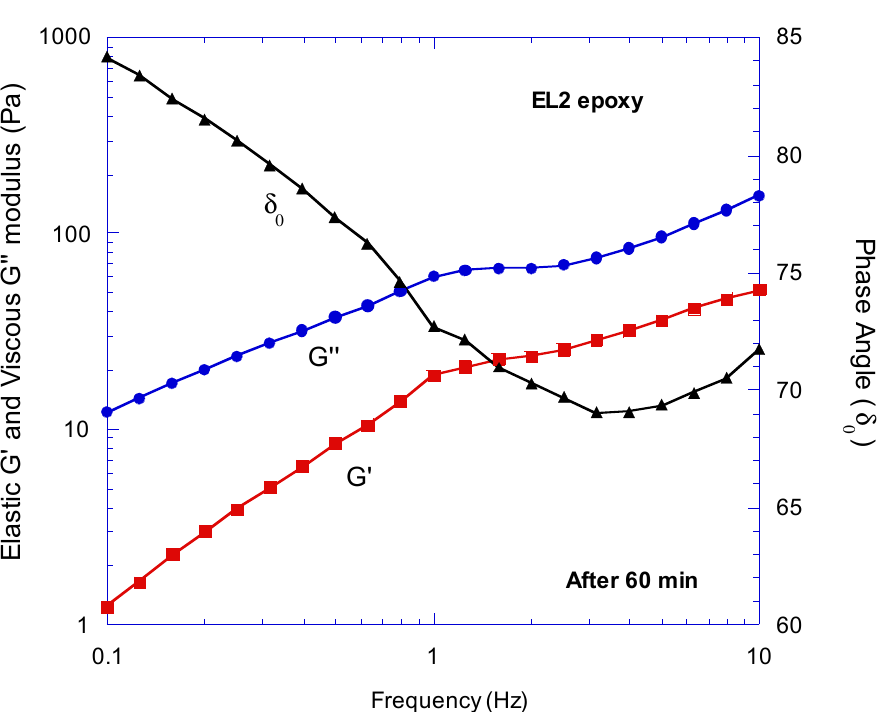
Figure 5. Frequency sweep result of EL2 epoxy 60 min after the mixing of the hardener.